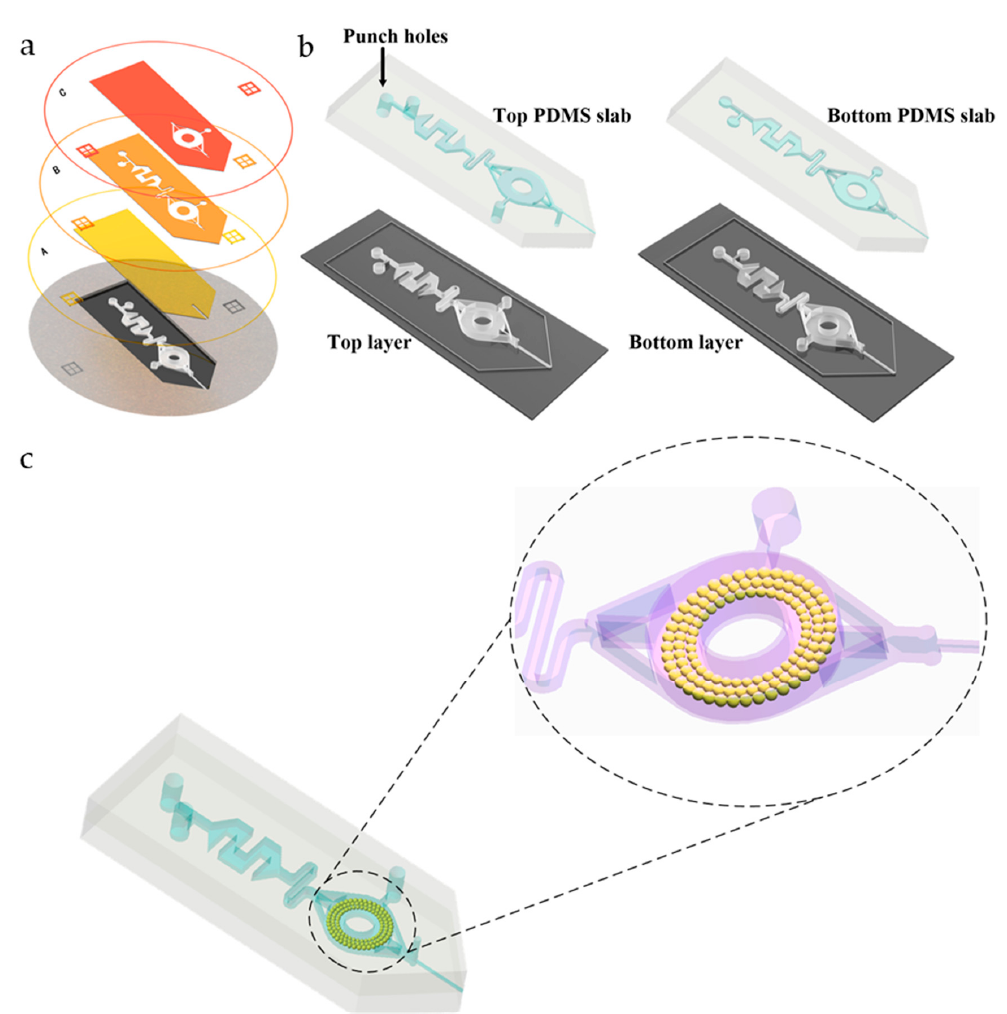
Figure 2. Manufacturing process of the microfluidic chip. ( a ) Photo Mask A shows the structure of the ESI emitter forming the features of 25 μ m. Photo Mask B shows the structure of the mixing and extraction channel forming the features of 100 μ m. Photo Mask C is to deepen the extraction channel forming the features of 100 μ m. The bottom diagram shows the SU ‐ 8 master mold of the microfluidic chip. ( b ) Schematic diagram of the casting process of the PDMS top layer and bottom layer. ( c) Schematic diagram of the bonding process of PDMS microfluidic chips and filling the C18 particles in the extraction